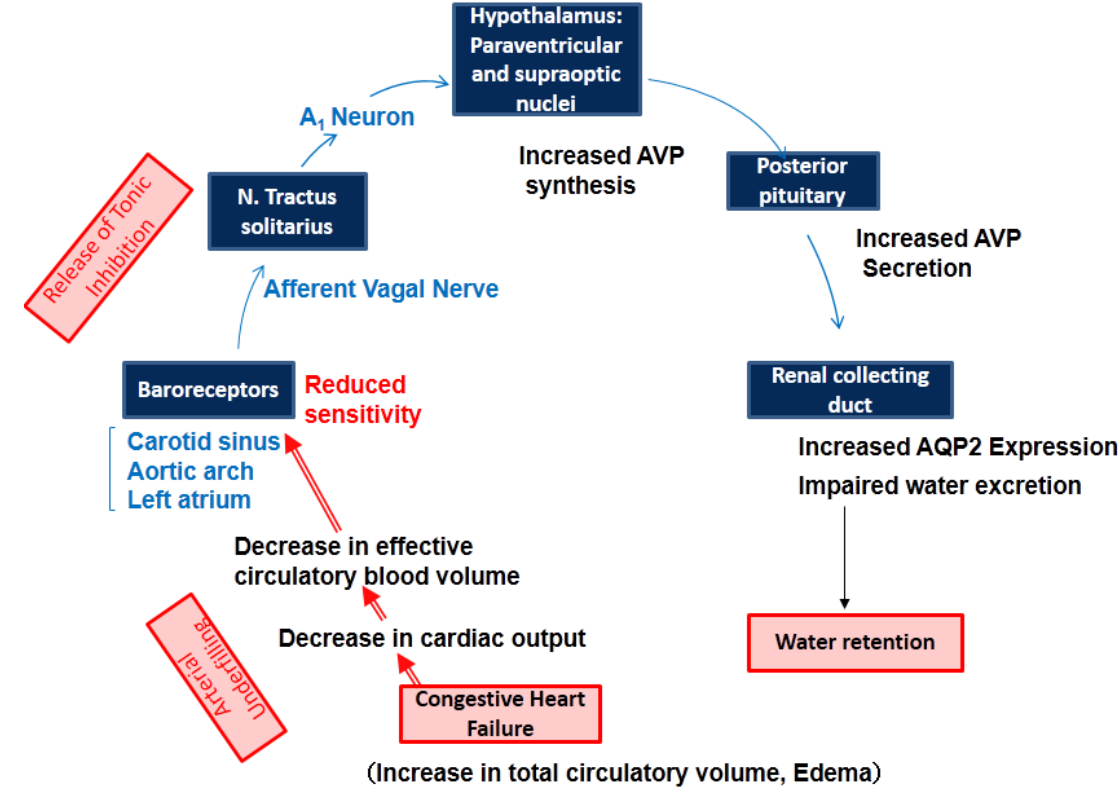
Figure 5. Pathological role of AVP in impaired water excretion in congestive heart